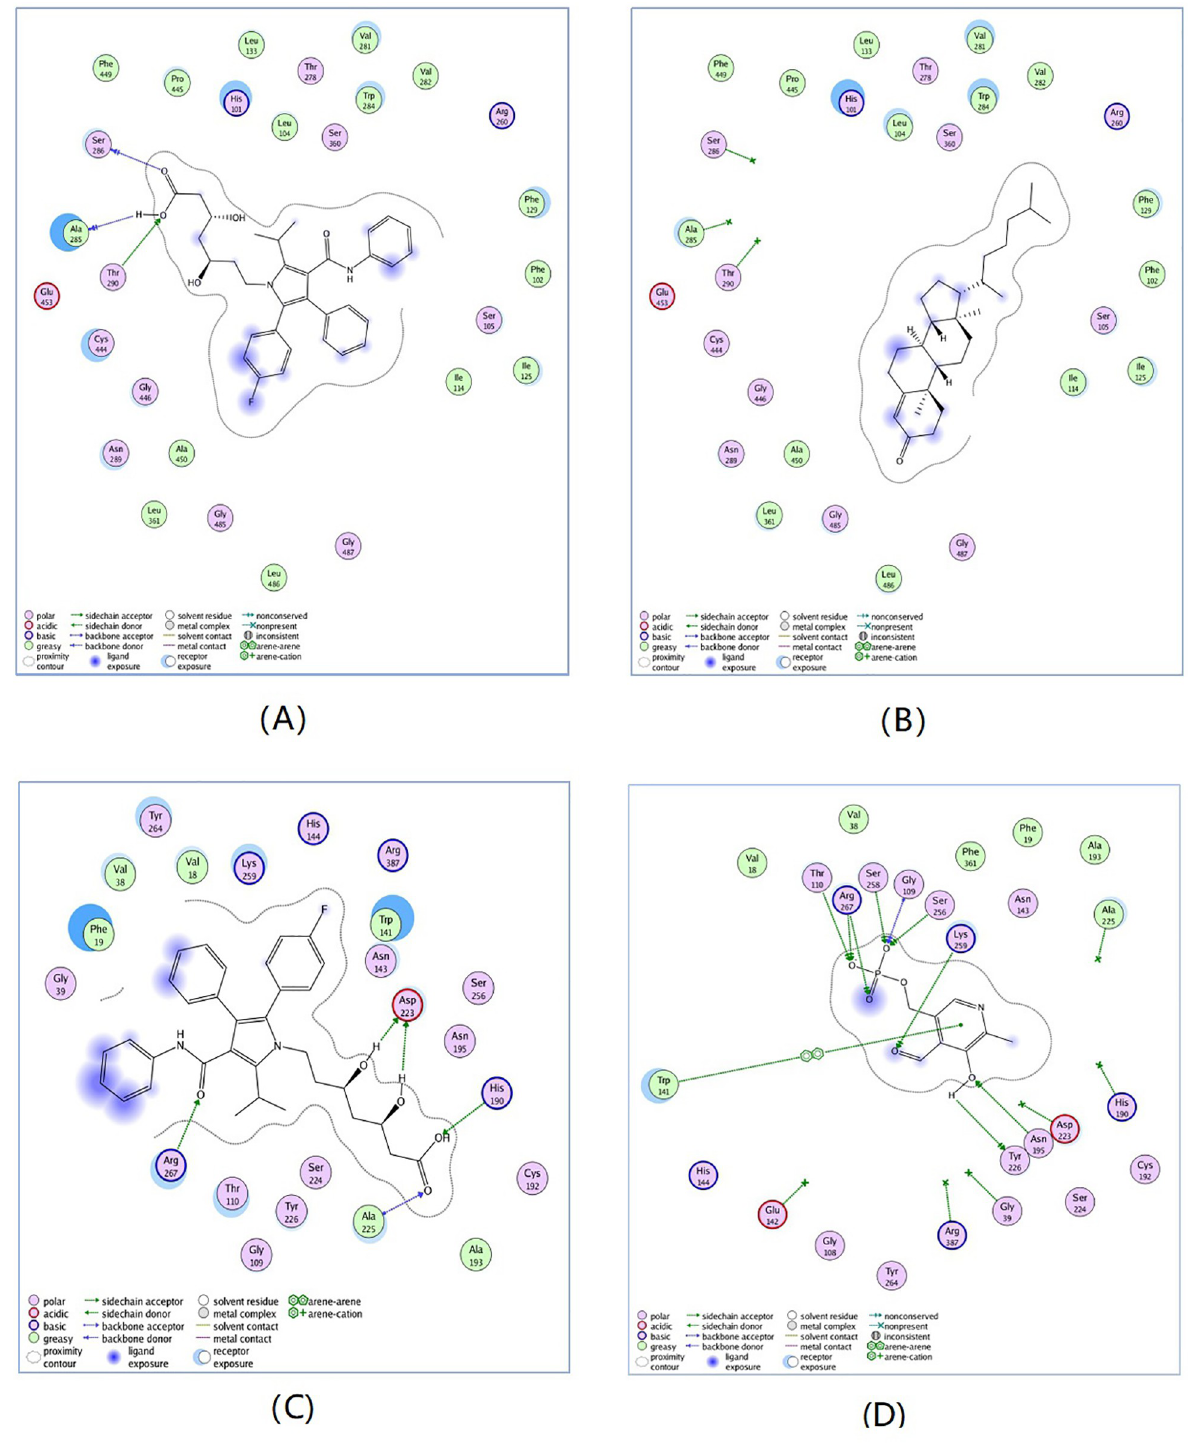
Fig 4. Comparison between the binding modes of atorvastatin. (A) and cholest-4-en-3-one; (B) in the Cyp7a1 active site and Atorvastatin; (C) and pyridoxal-5’-phosphate; (D) in the Got1 active site.